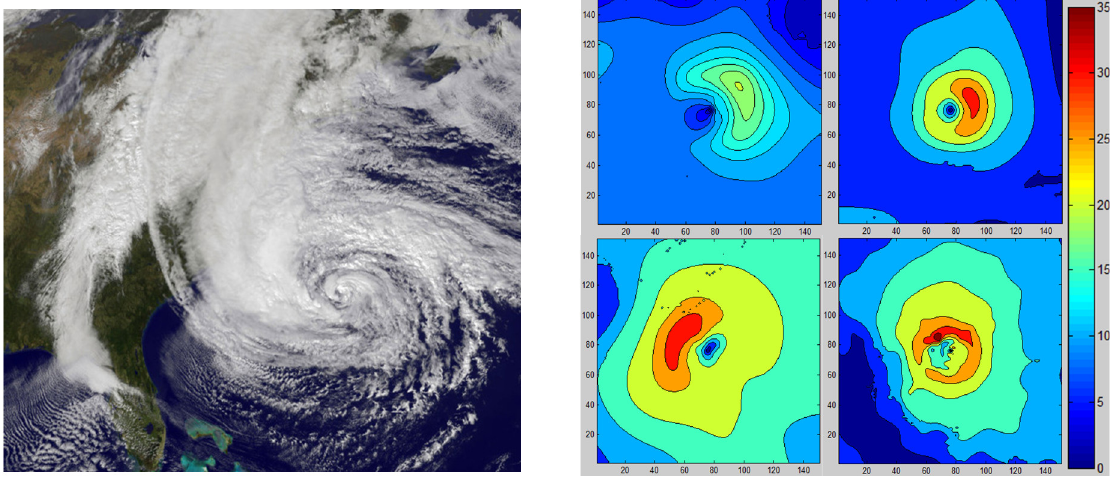
Figure 9. The image on the left shows Hurricane Sandy from a satellite view (source: www.nhc.noaa.gov/data; accessed on 15/01/2013), on which wind velocity and directions measurements are based. The images on the right represent the wind speed magnitude (in m/s) across a 150 × 150 grid, with 10 km resolution, centralized to the eye of the hurricane observed on (from upper left to lower right) 23, 25, 27 and 29 October 2012 (more details in [40]).